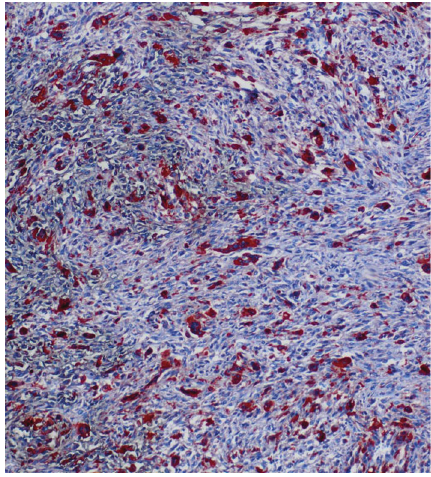
Figure 4: Immunohistochemical CD68 staining of the malignant fibrous histiocytoma ( ×